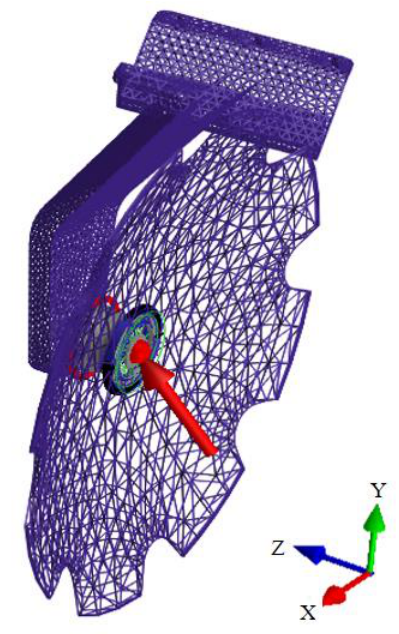
Figure 8. Loading condition of disk harrow